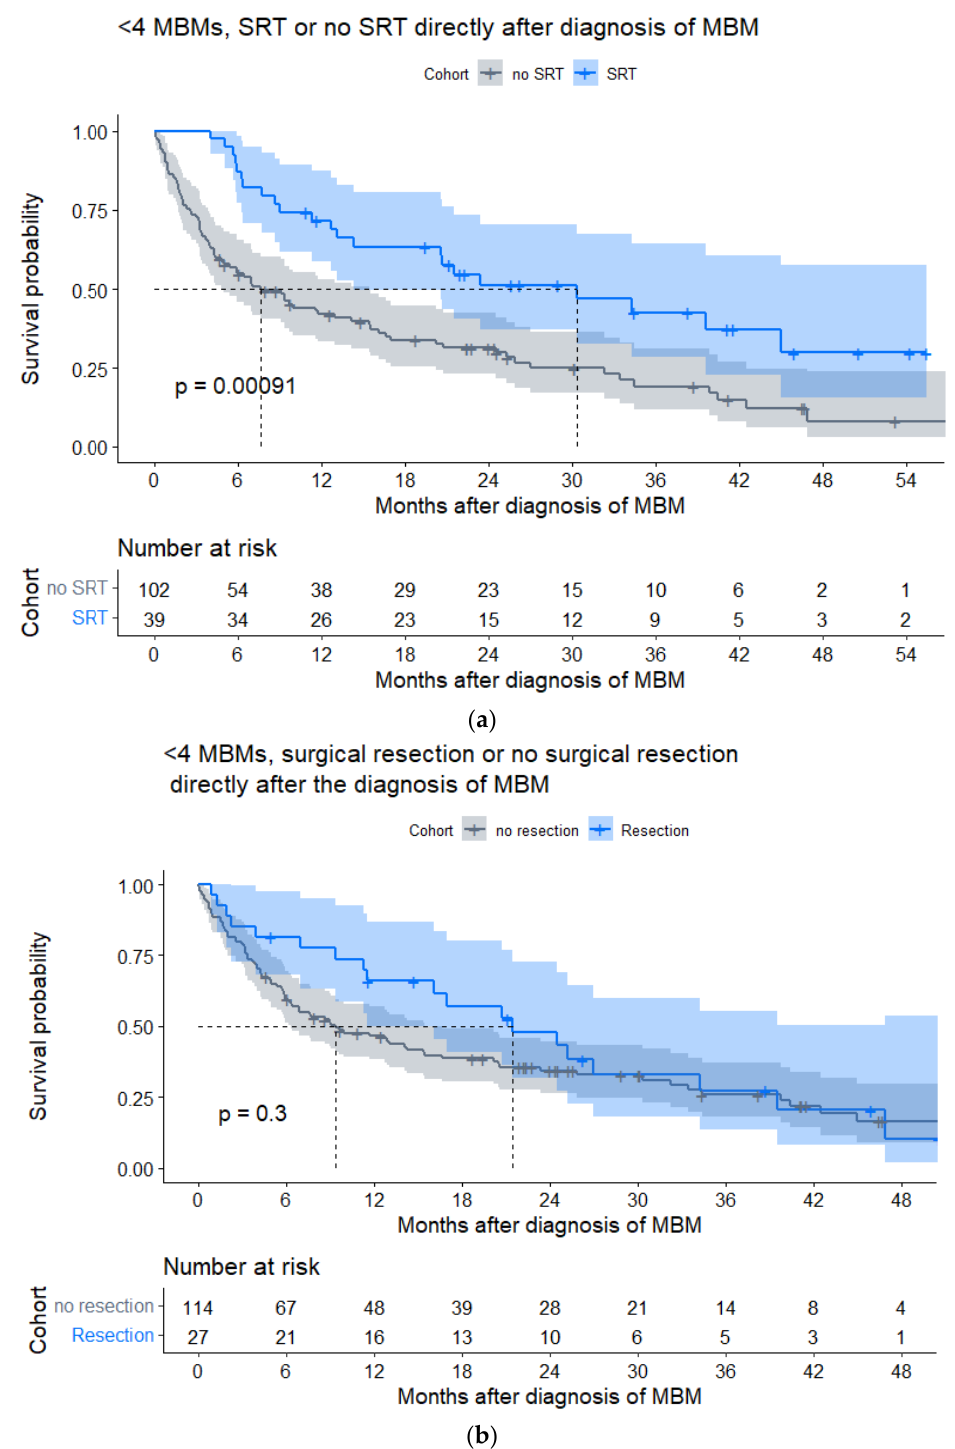
Figure 3. Kaplan – Meier estimates for local treatments in patients with melanoma brain metastasis (MBM) of the post-2015 cohort and with <4 MBMs ( n = 141). ( a ) Stereotactic radiotherapy (SRT) versus no stereotactic radiotherapy (no SRT) directly after diagnosis of MBM. ( b ) Surgical resection versus no surgical resection directly after diagnosis MBM.